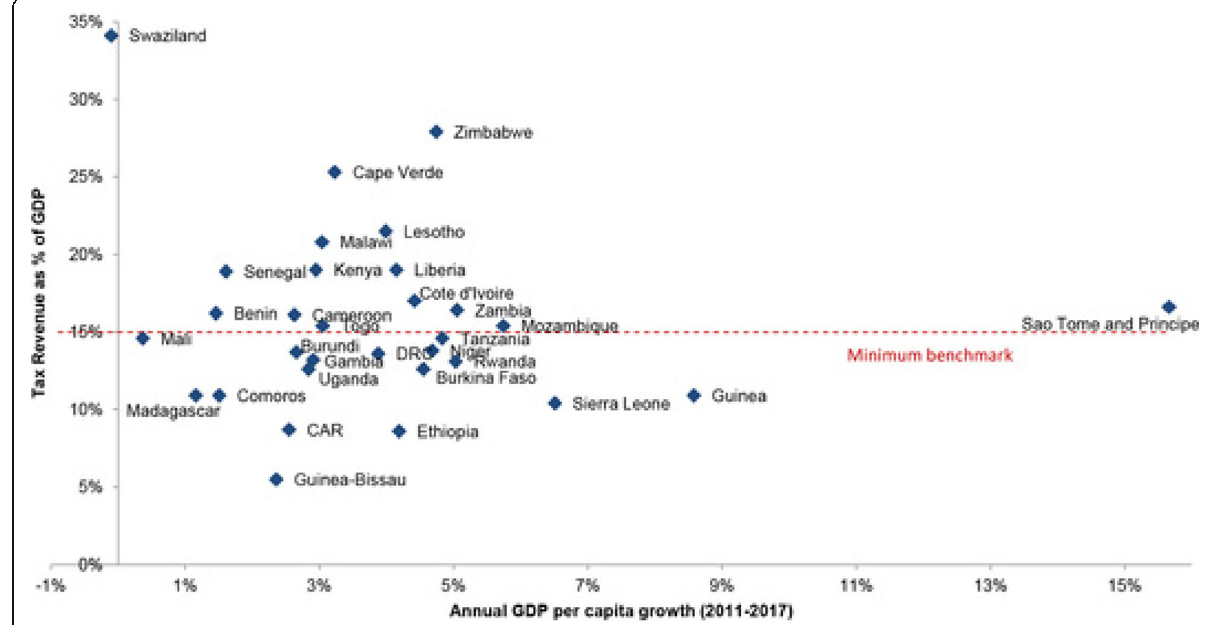
Fig. 3 Growth and taxation rates in low- and lower middle-income